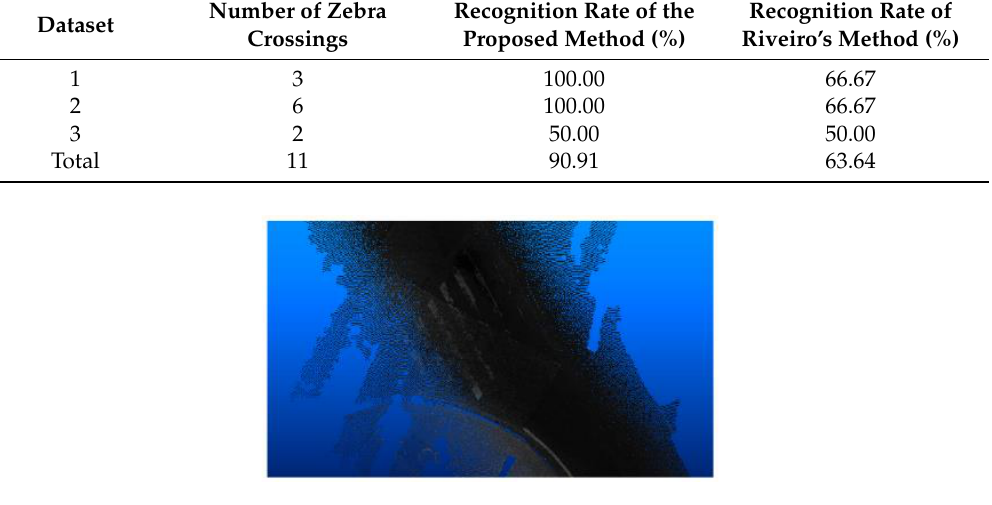
Figure 16. The unrecognized zebra crossing.